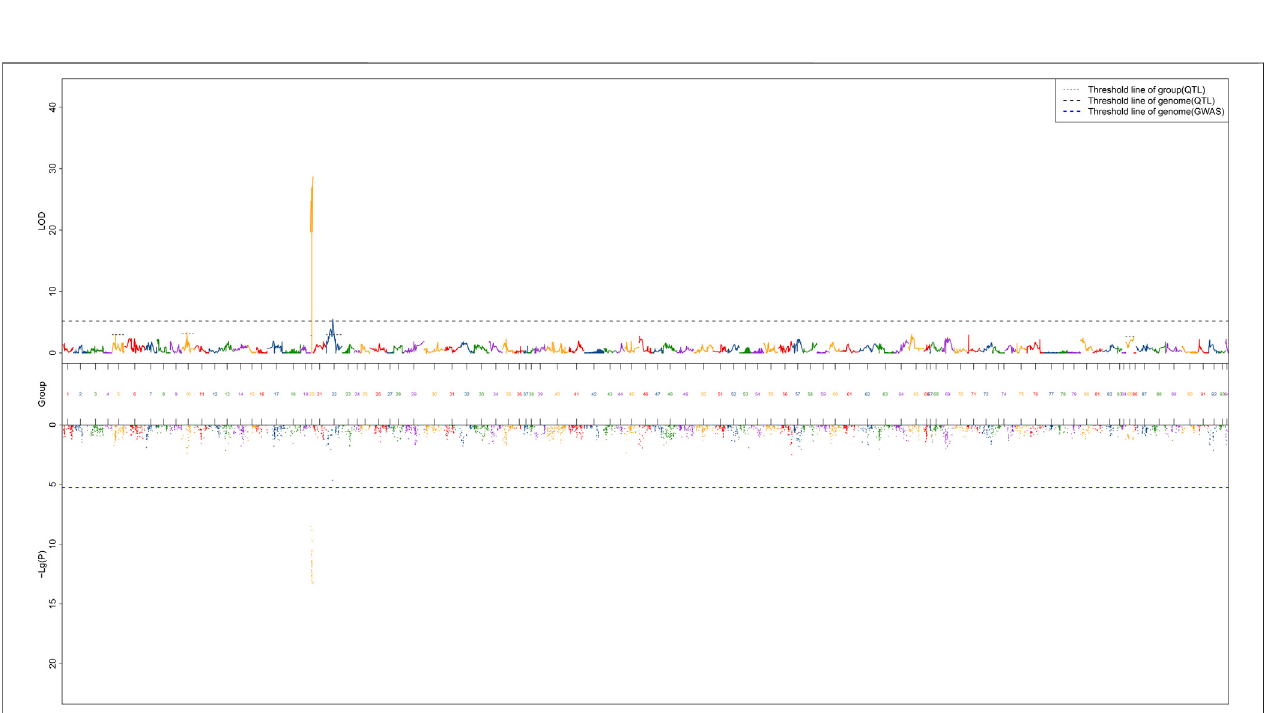
FIGURE 4 | QTL mapping of sex traits of red swamp cray fi sh. The length of each linkage group is plotted as the coordinate distance in the x -axis.